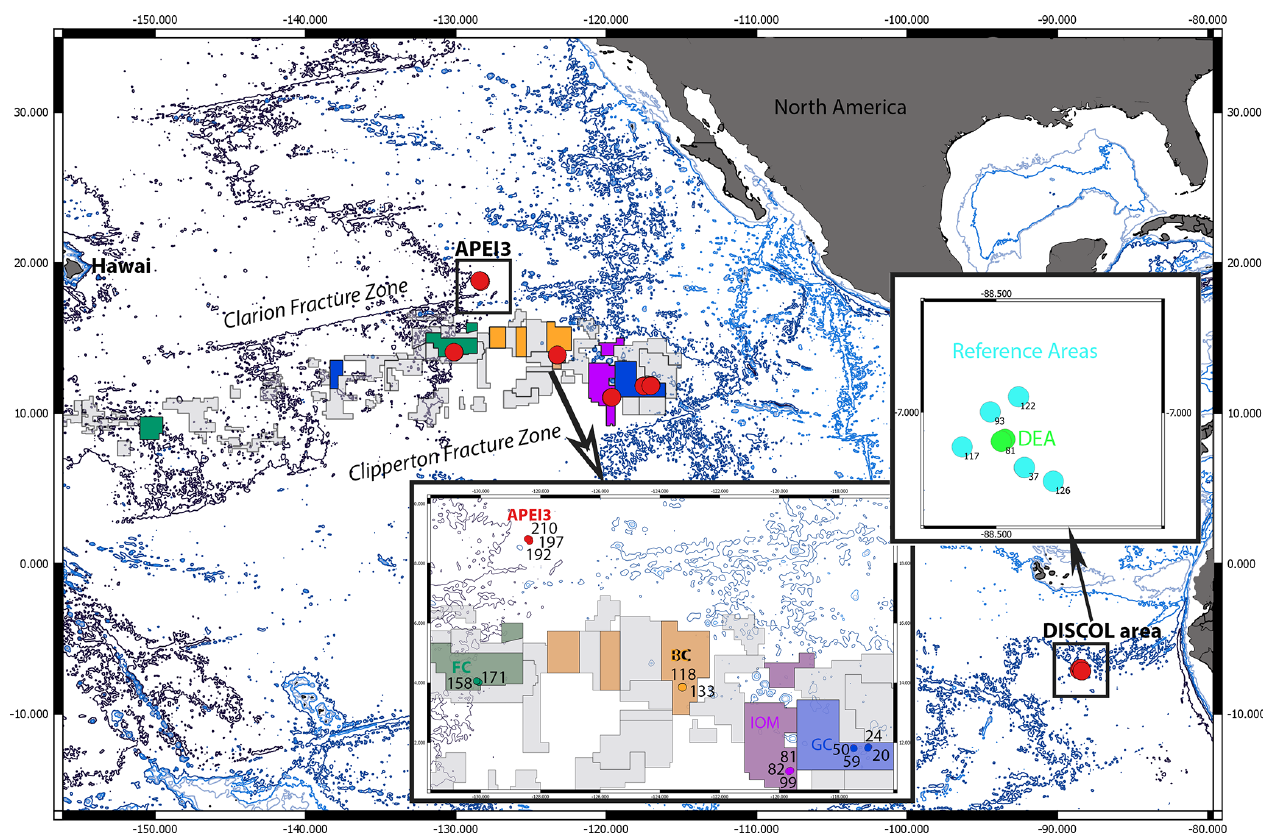
Figure 1. Map of the locations of the epibenthic sledge (EBS) sampling sites (red dots) within the manganese nodule contractor area and the DISturbance and reCOLonization experiment (DISCOL) Experimental Area (DEA) in the northeastern and southeastern Pacific. The color code in this map reflects the color code given in the circle trees (Figs. 2–5) but is not reflected in the statistical graphs (Figs. 6–10). In the CCZ, the samples were taken in four contractor areas from east to west: GC (dark blue – German contractor: BGR), IOM (violet – Interoceanmetal Joint Organization), BC (orange – Belgian contractor: GSR), and FC (dark green – French contractor: IFREMER). In addition, the APEI3 (red – Area of Particular Environmental Interest number 3) and DISCOL Experimental Area (light green/blue – DEA and reference